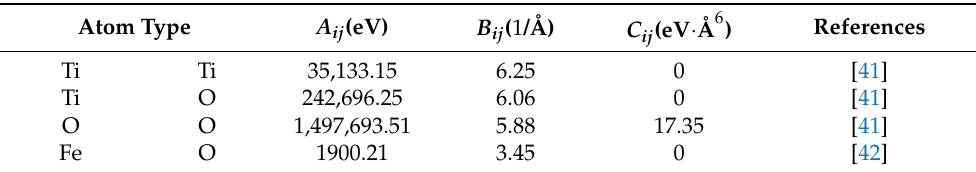
Table 2. Potential parameters for Ti-Ti, Ti-O, O-O, and Fe-O interactions with BMH (Born- Mayer − Huggins) potential.